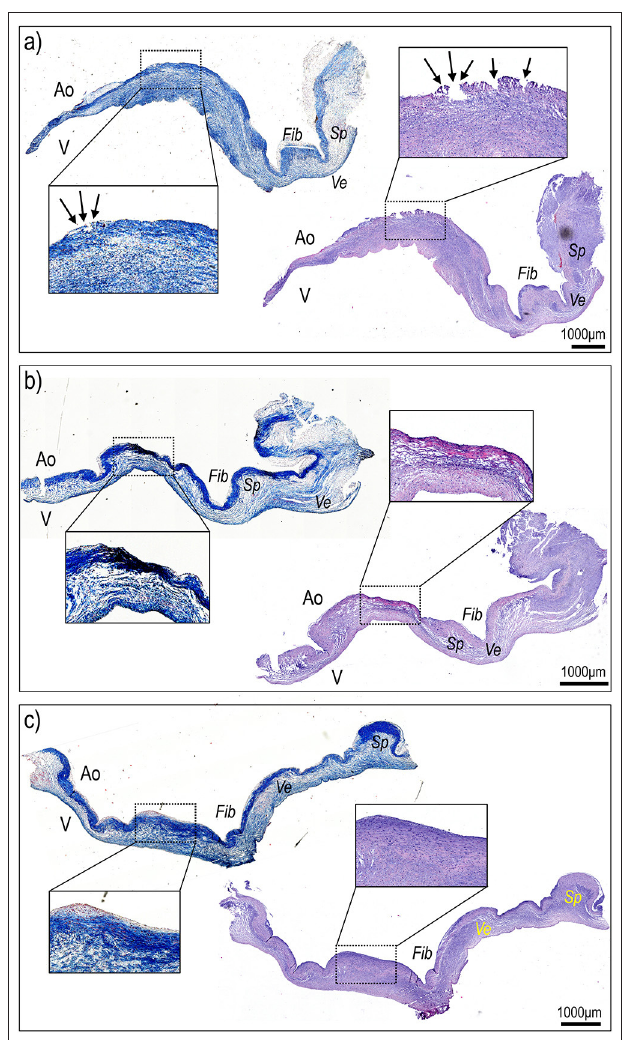
FIGURE 5 | Histological sectioning of the right (a) , non-coronaric (b) , and left (c) leaflets of the aortic valve treated with TDD in Figure 4 from commissure to commissure and along a radial direction stained with hematoxylin/eosin and Masson’s staining solutions. The right leaflet, treated with the TDD (a) , showed evident signs of superficial damage (arrows in magnification inset) that were contained within the superficial portion of the fibrosa (Fib) identifiable on the aortic (Ao) side of the valve due to its intense blue staining. In no case the ventricular portion (V) or the ventricularis (Ve) or the spongiosa (Sp) layers exhibited signs of tissue